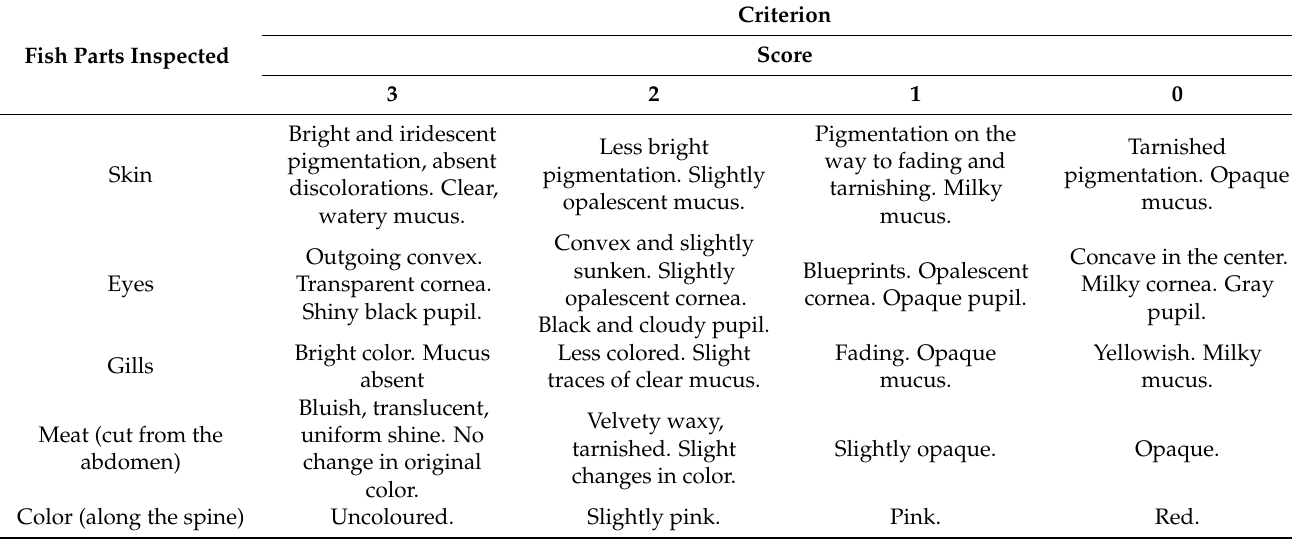
Table 9. Appreciation of the freshness of the fish. Council Regulation (EEC) N° 103/76 OJ N° L20 (28 January 1976) [53]. Criterion Score Fish Parts Inspected 3 2 1 0 Pigmentation on the Bright and iridescent Tarnished Less bright way to fading and pigmentation, absent pigmentation. Opaque pigmentation. Slightly tarnishing. Milky discolorations. Clear, mucus. opalescent mucus. mucus. watery mucus. Convex and slightly Concave in the center. sunken. Slightly Blueprints. Opalescent Milky cornea. Gray opalescent cornea. cornea. Opaque pupil. pupil. Black and cloudy pupil. Fading. Opaque Yellowish. Milky mucus. mucus. Slightly opaque. Opaque. Slightly pink. Pink.